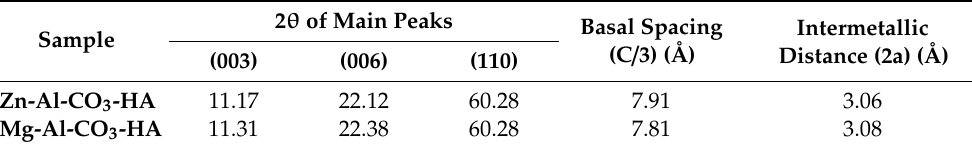
Figure 2. XRD analysis of Zn-Al-CO3-HA and Mg-Al-CO3-HA LDHs. Table 2. Crystallographic parameters of the samples.